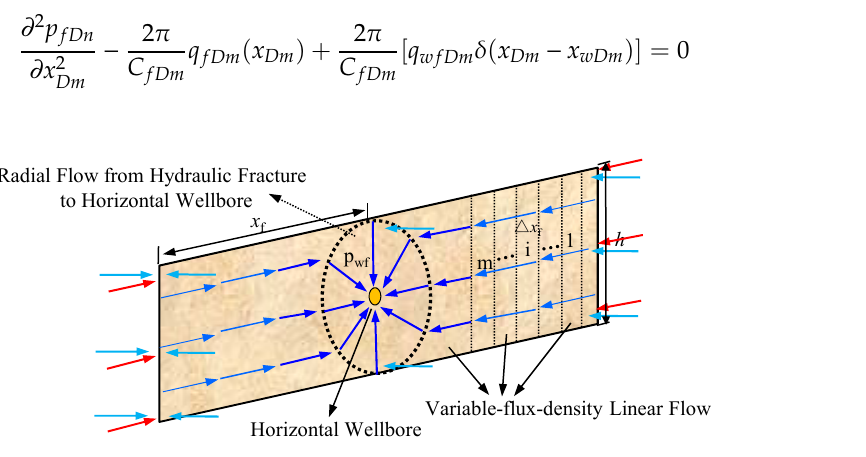
Figure 5. Schematic of the flow pattern in the transverse fracture.